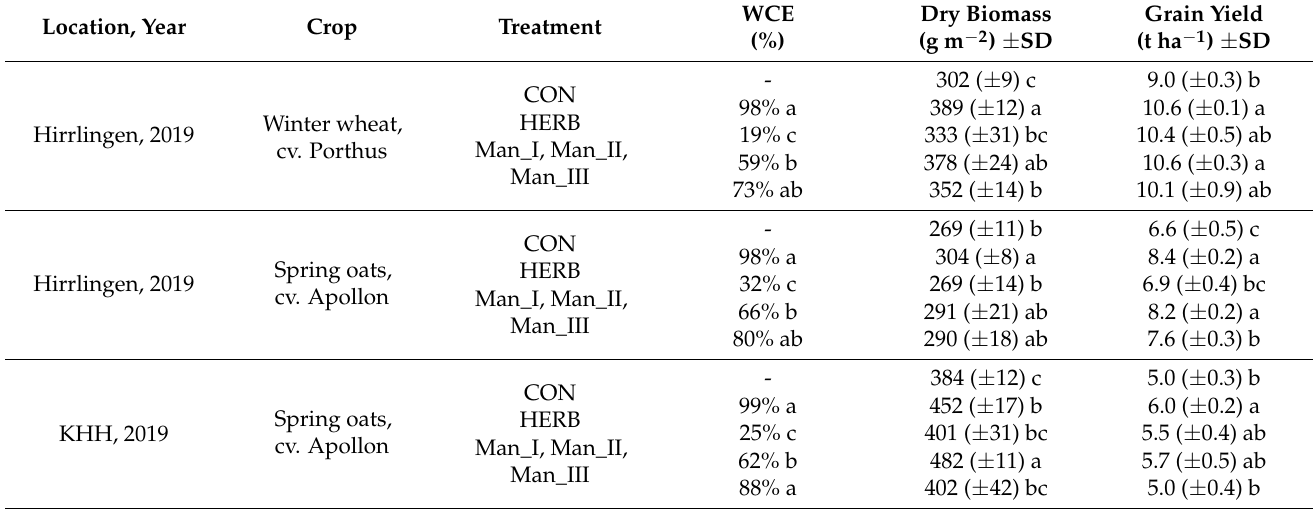
Table 4. Weed control efficacy (WCE, %, ± SD), crop dry biomass (g m − 2 , ± SD), and grain yield (t ha − 1 , ± SD) of the experiments in Hirrlingen and KHH in 2019. Means with the same letter within a column are not significantly different according to HSD-test at p ≤ 0.05. Levels of significance are given for each experiment separately. Location, Year